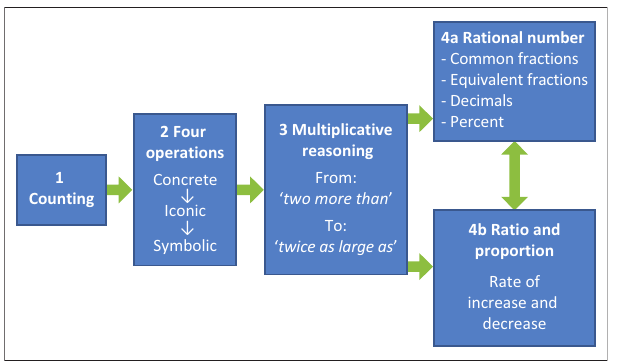
FIGURE 1: The trajectory of the number